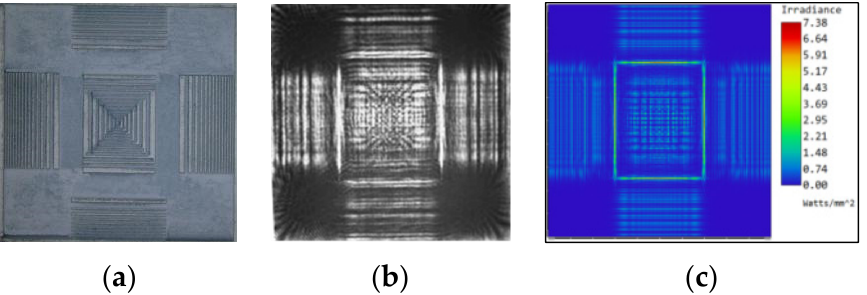
Figure 13. ( a ) the rectangular PB-FZPs processing by fs-laser; ( b ) corresponding diffraction perfor- mance; and ( c ) corresponding simulated results.